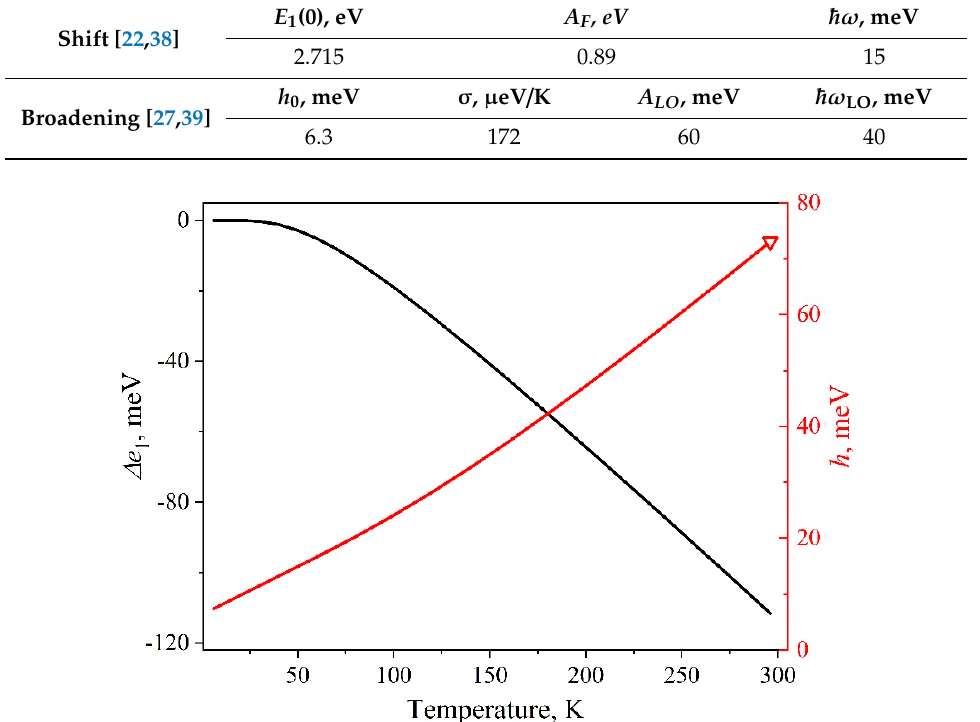
Figure 3. Energy shift (black line, calculated by the Equation (4)) and broadening (red line, calculated by the Equation (1)) of the exciton peak for an individual InP / ZnS nanocrystal. Open triangle—data from [39].